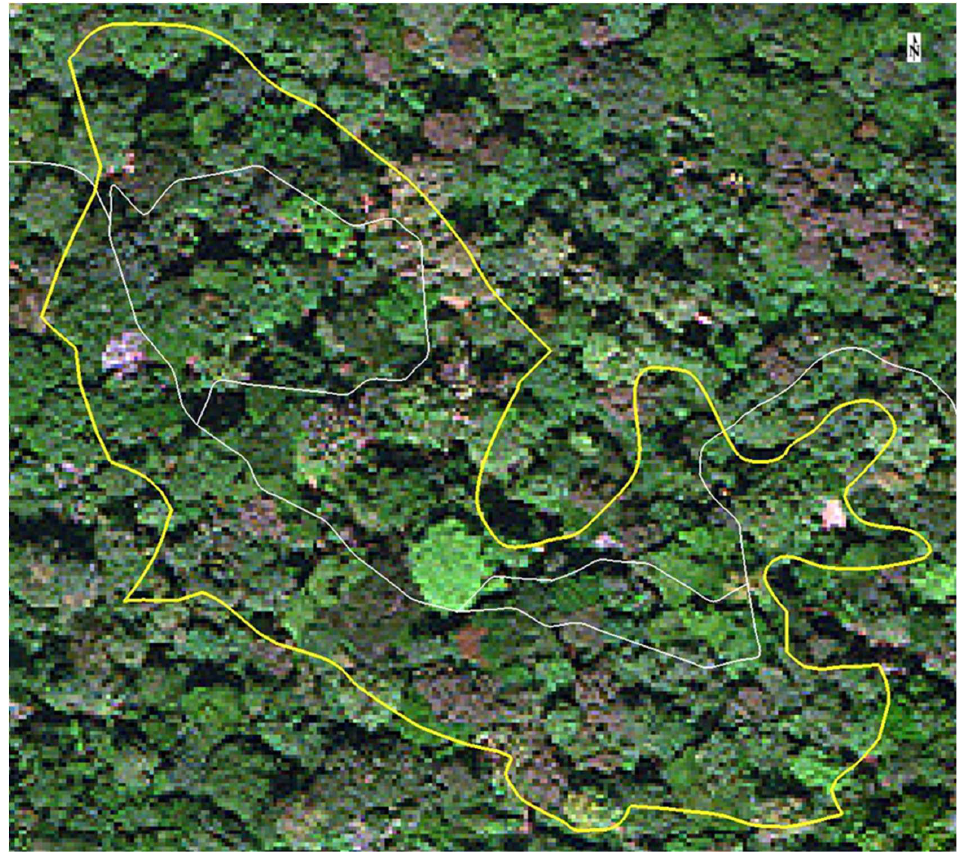
Figure 2. A true-color composite WorldView-3 image of the Holdridge Arboretum. The outline of the Arboretum boundary is in yellow. Trails into and through the Arboretum are in white. Tree canopies are evident in the multispectral imagery. Please refer to Table 1 for imagery specifications.